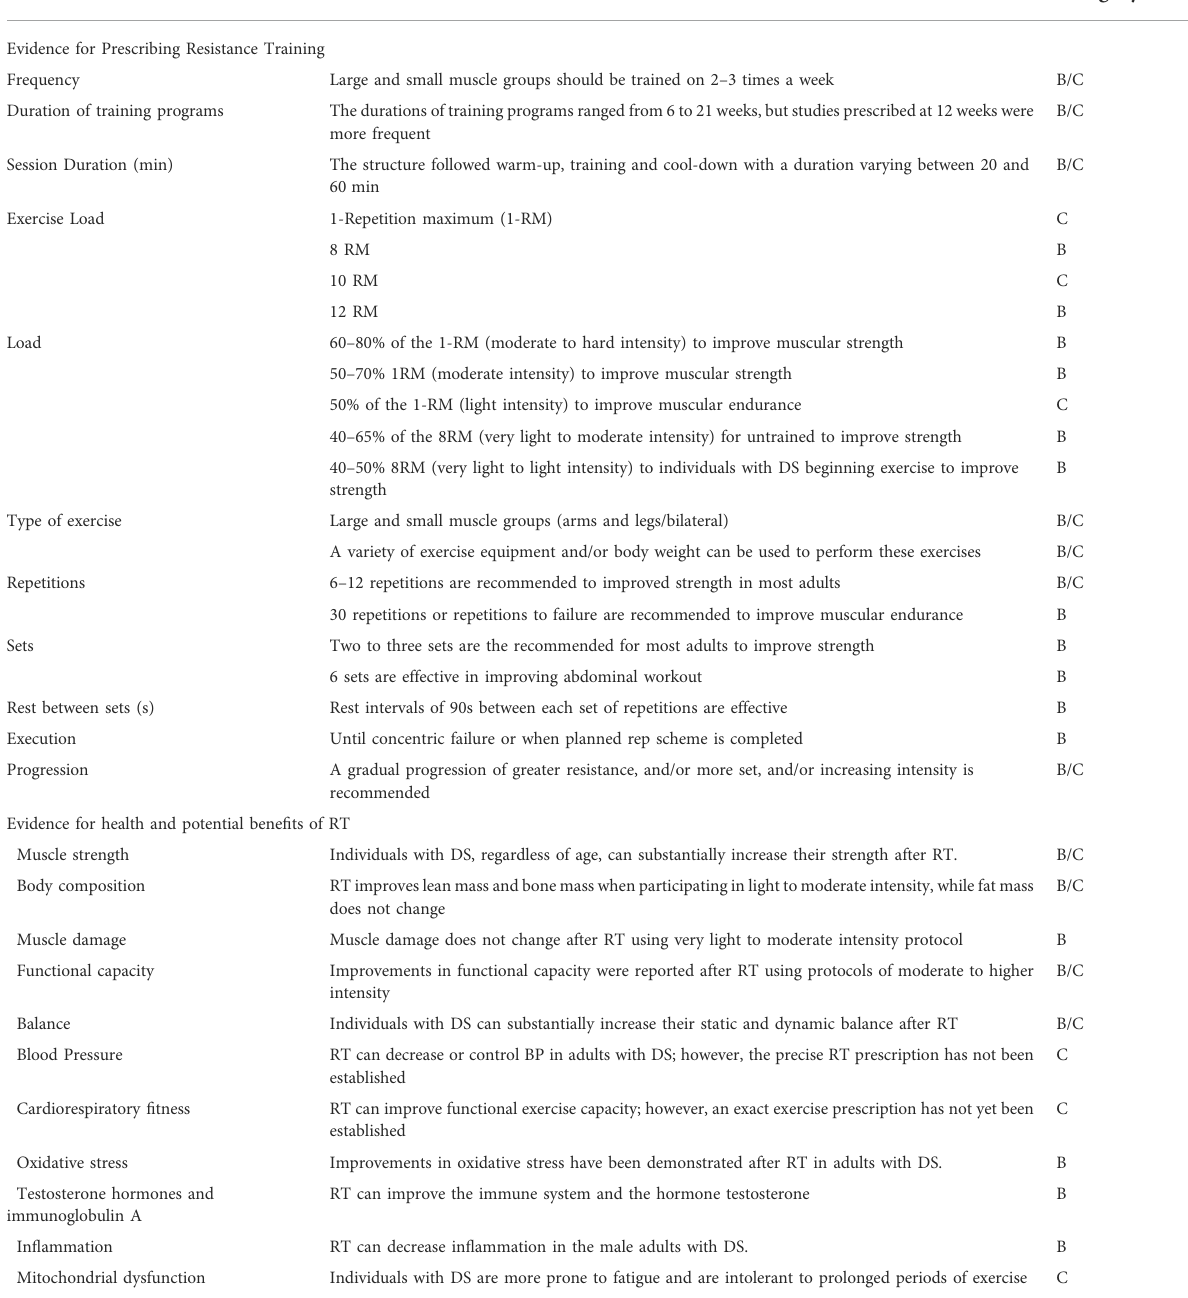
TABLE 2 Evidence statements and summary of recommendations for the individualized resistance training prescription in individuals with